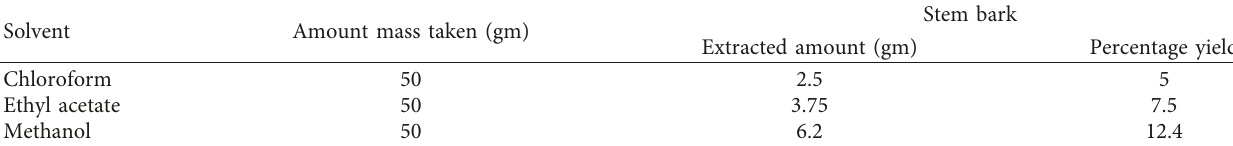
Table 1: Different mass of extracts were recorded from the stem barks of S . gigas .